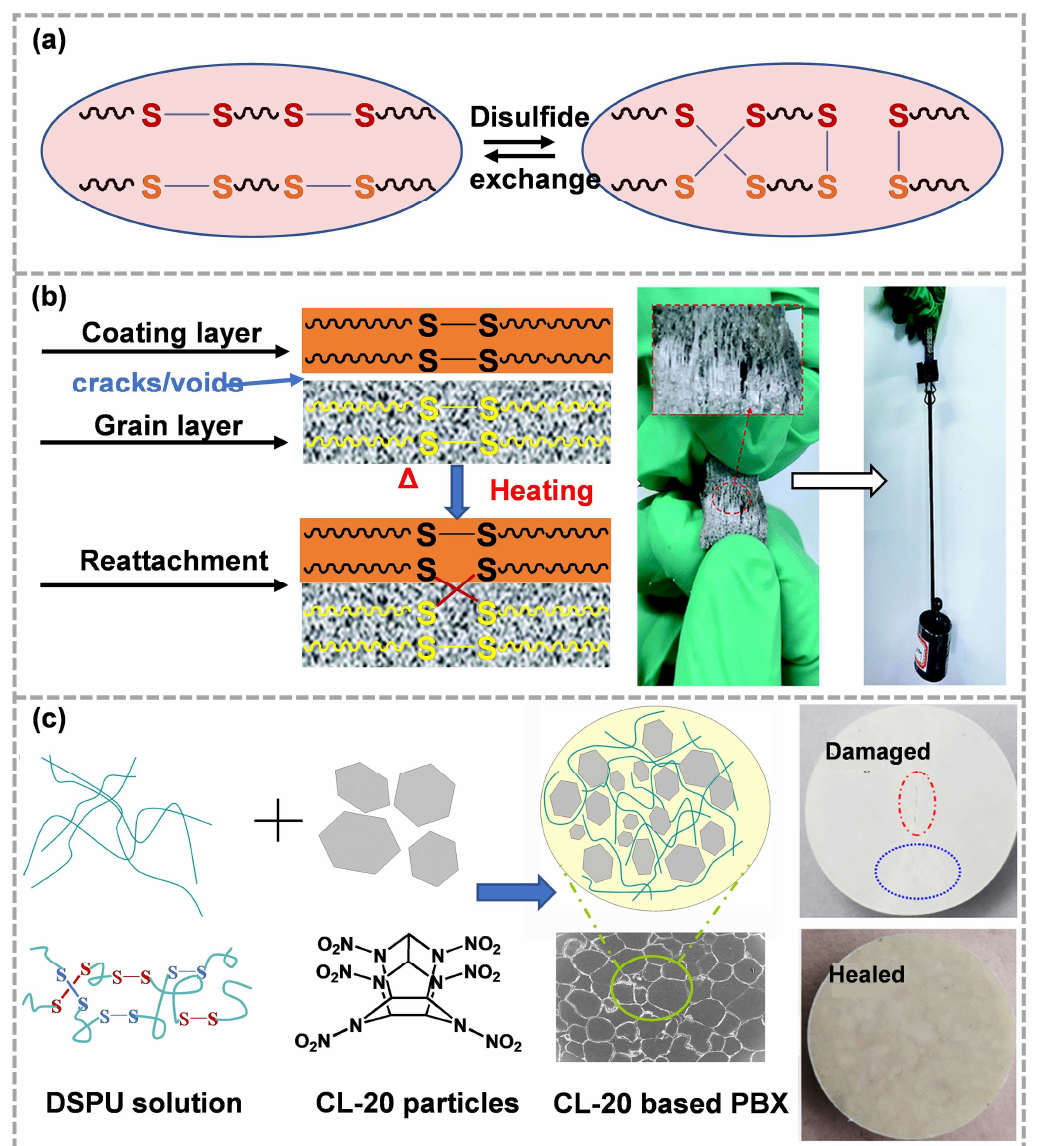
Figure 4. ( a ) Disulfide chain exchange (reproduced from Ref. [63] with permission; Copyright Springer Nature, 2020), ( b ) the self-healing of the debonding interface between the grain and coating layer(reproduced from Ref. [70] with permission; Copyright Royal Society of Chemistry, 2020), ( c ) the preparation and the damage self-healing of CL-20-based PBX using DSPU as binder(reproduced from Ref. [71] with permission; Copyright Elsevier, 2019).